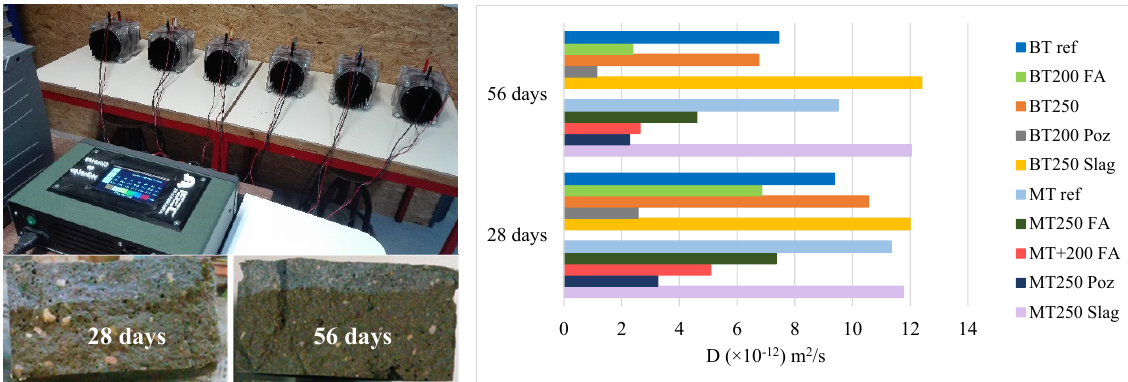
Figure 8. Chloride migration (left) and D coe ffi cient at 28 and 56 days for BT and MT mixtures